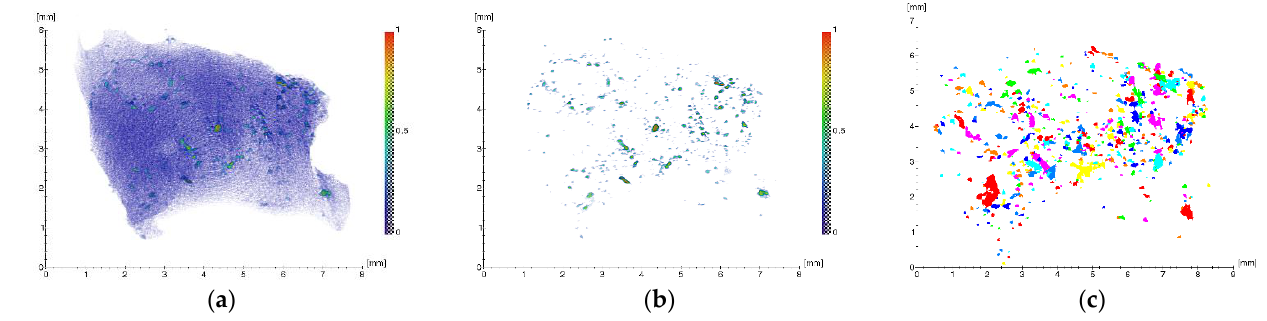
Figure 2. Three-dimensional reconstruction of the specimen (fibrous capsule): ( a ) initial image with foreign inclusions; ( b ) image of the foreign inclusions after the segmentation procedure; ( c ) the resulting projection of the foreign inclusions after the segmentation procedure.